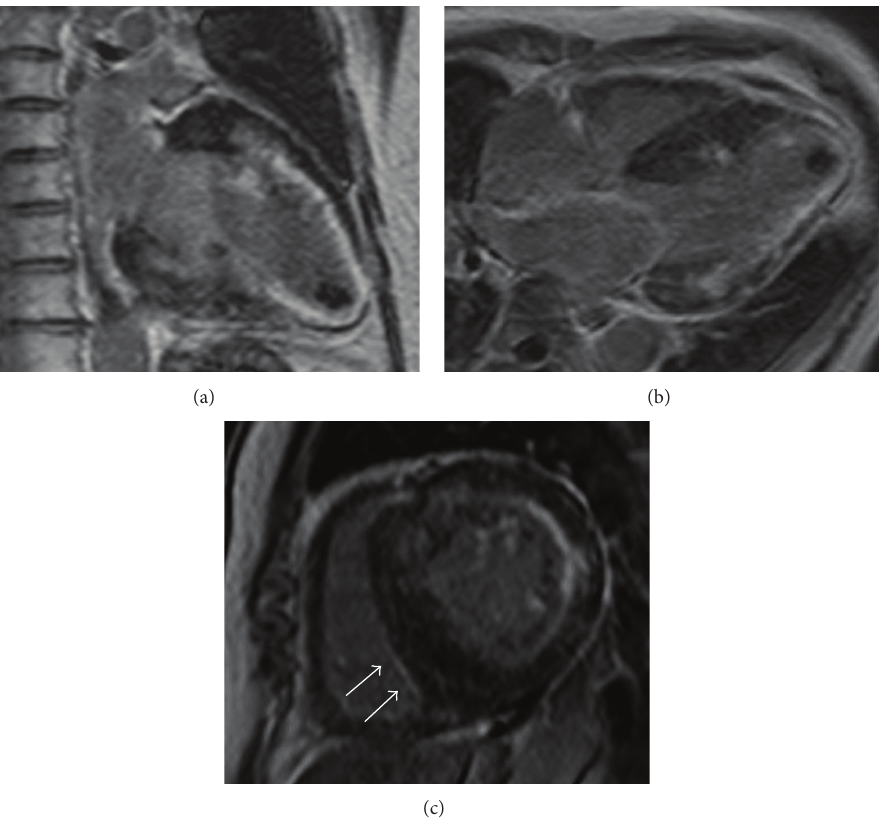
Figure 3: The long-axis view (a), four-chamber view (b), and short axis view (c) of cardiac magnetic resonance imaging revealed a thin-walled apical aneurysm, with subendocardial late gadolinium enhancement (LGE) in an extensive area of the mid-to-apex region of the left ventricle and in a smaller area of the right ventricle (small arrows). LGE involved the majority of the basal lateral wall. Smaller midmyocardial LGE located in the basal interventricular septum, the wall of which was markedly thickened, was also observed. Scanner type: 3D-FFE, matrix scan: 224, flip angle: 15 degrees, and bandwidth: 324.7 Hz. The repetition time, echo time, and inversion time were (a) 3.910, 1.219, and 280 m/s, (b) 4.005, 1.250, and 290 m/s, and (c) 4.078, 1.272, and 300 m/s,